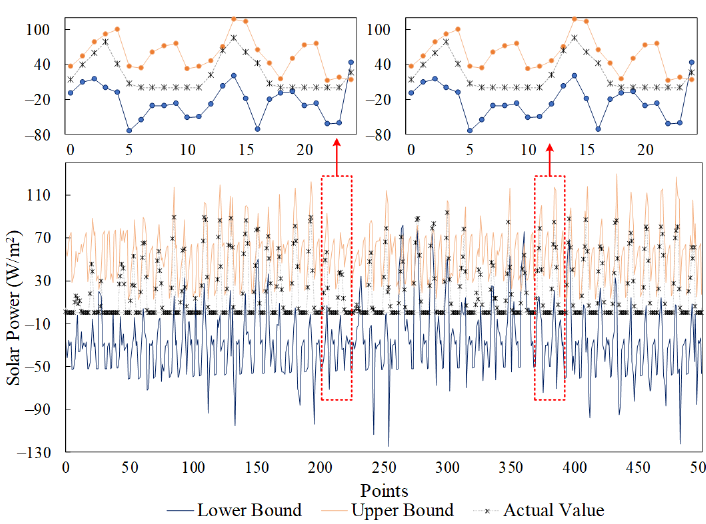
Figure 6. The prediction result obtained by PSO and RI with ELM-AE. Table 2. Comparison of average results of different cases with ELM-AE.